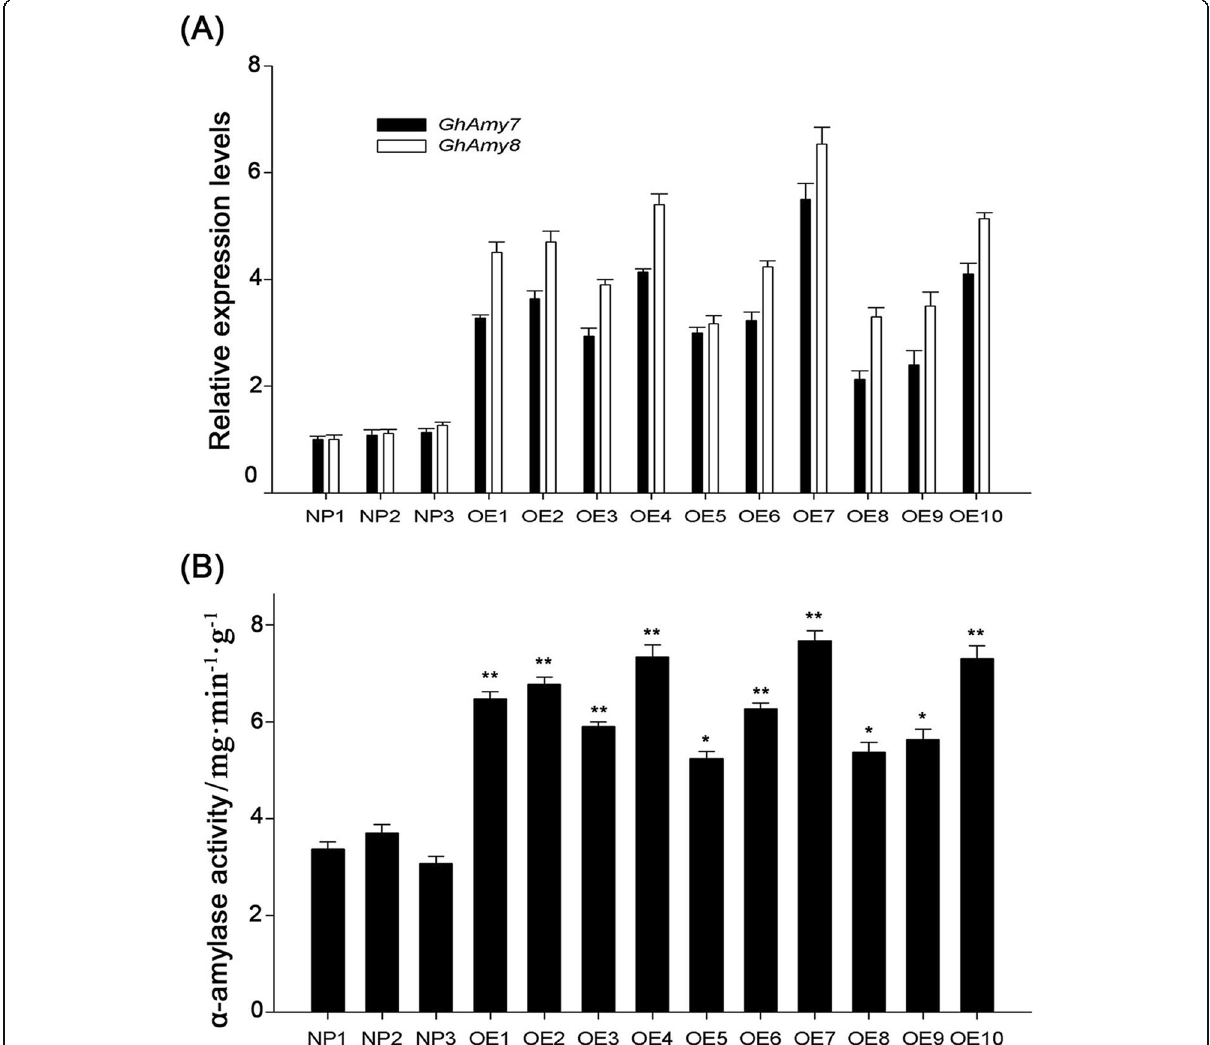
Fig. 3 Overexpressing OsLOL1 promotes GhAmy7 and GhAmy8 expression and α -amylase activity in embryogenic calli. a Relative expression levels of GhAmy7 and GhAmy8 in the embryogenic calli with OsLOL1 or empty vector. Bars represent SD from three biological repeats. b α -amylase activity of the embryogenic calli with OsLOL1 or empty vector. Bar represents SD from three biological repeats. One asterisk or double asterisks show significant ( P < 0.05) or extremely significant ( P < 0.01) differences of OEs compared with NP1 by Student ’ s t